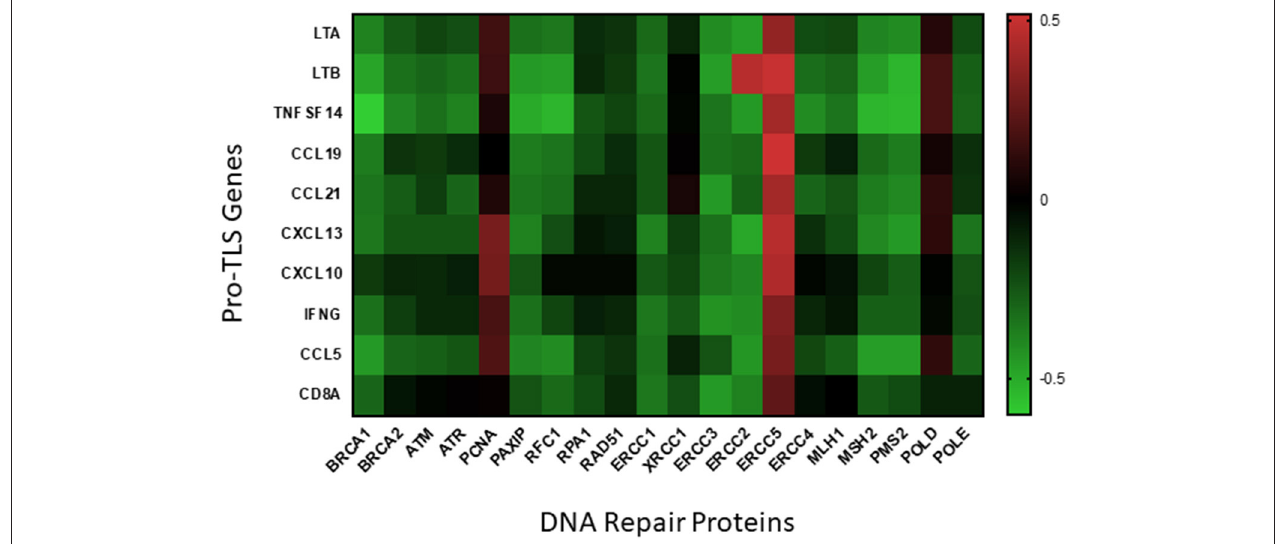
FIGURE 1 | Correlation of DNA repair proteins with pro-TLS genes. TCGA data from two cohorts of cutaneous melanoma patients (SKCM_DFCI 2015 and SKCM_MSKCC 2014) was included to analyze if expression of DNA repair proteins correlated with the expression of inflammatory markers within the TME. TCGA data was uploaded onto cBio Portal, a published TCGA data analysis tool ( 86, 87), and correlative mRNA expression of the above inflammatory and DNA repair proteins visualized using linear regression models. Pearson’s coefficients from each correlation is visualized as a heatmap (created using the Prism 8 software) above with positive correlations indicated in red and negative correlations indicated in